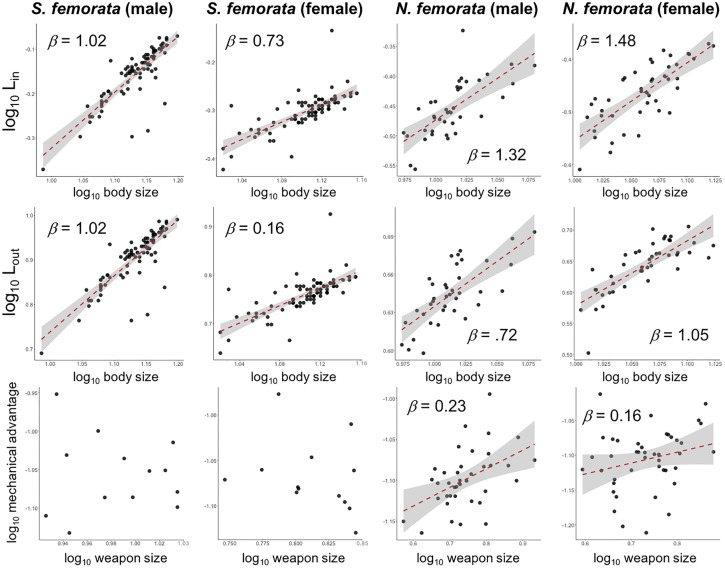
Relationships between lever components/mechanical advantage and body size for A) S. femorata males, B) S. femorata females, C) N. femorata males, and D) N. femorata females.Top: Lin vs. body size. Middle: Lout vs. body size. Bottom: mechanical advantage vs. body size. Red lines represent OLS regression. Shaded areas represent 95% confidence intervals around OLS regressions. Lines omitted for non-significant regressions.